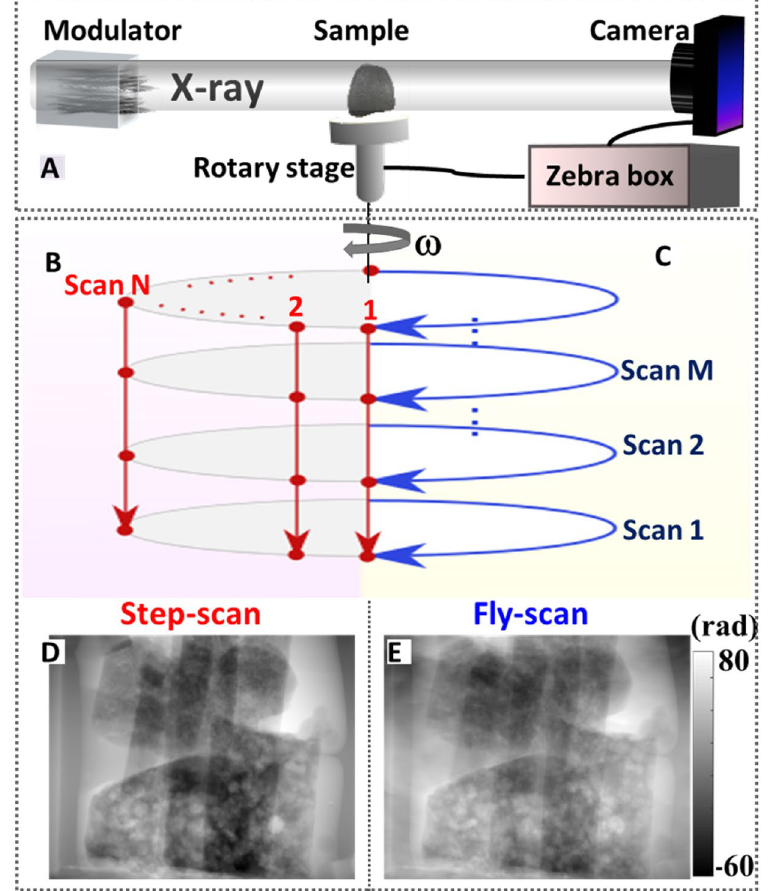
Figure 1. ( A ) Schematic illustration of the experiment setup at I12 beamline. The fly-scan scheme is implemented with a Zebra box control system by synchronizing the rotary stage position and camera triggering signal. ( B ) For speckle-based phase tomography with the standard step-scan scheme, the sample is held stationary while the modulator is stepped through M positions across the beam, and the modulator will be repeatedly scanned when the sample is rotated at all the projections N. ( C ) For the proposed fly-scan scheme, the tomography rotation is performed continuously with projection N at different modulator position M. ( D ) The reconstructed phase images from one projection by using the step-scan scheme. ( E ) The reconstructed phase images taken by using the fly-scan scheme with the same